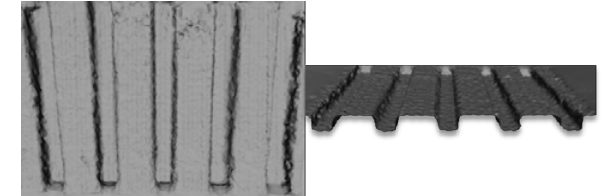
Figure 8: Mesh result of the beam (two different views)